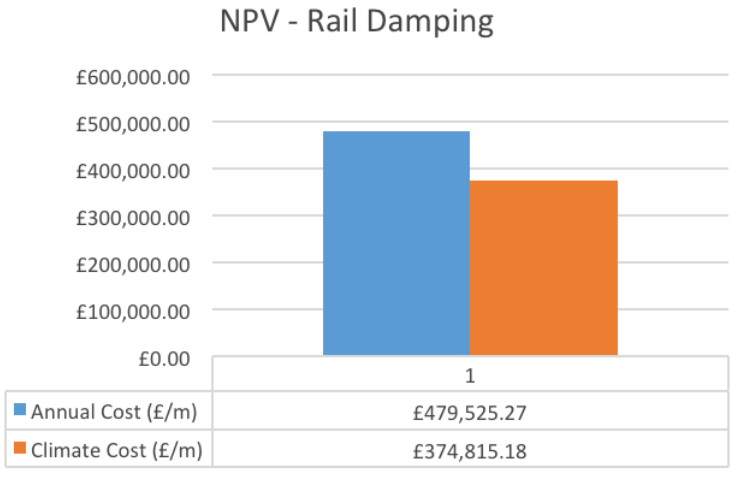
Figure 11. Net present values for rail damping.